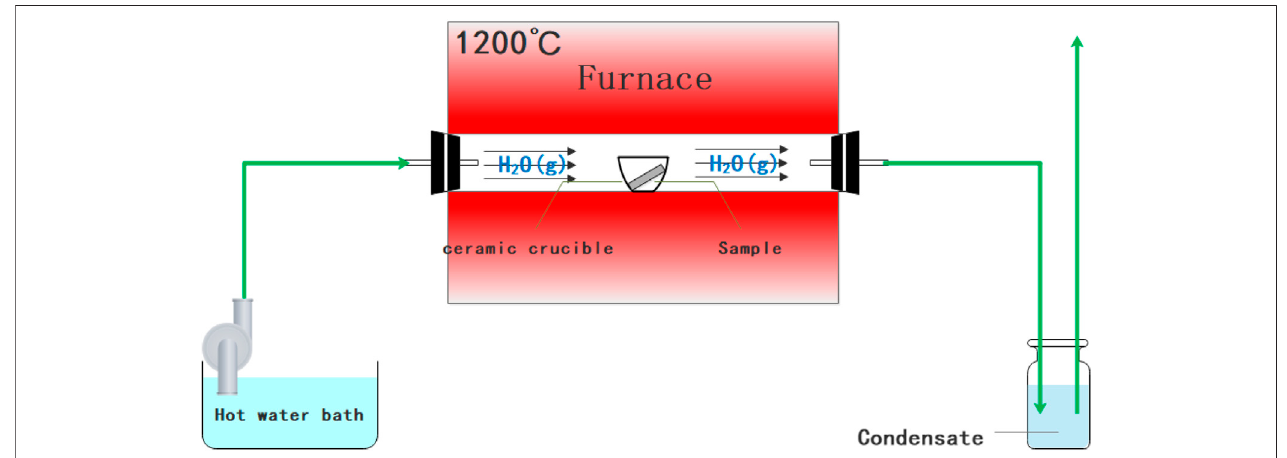
FIGURE 1 | Schematic diagram of a controlled environment fi reside corrosion test setup (Qiao et al., 2020).